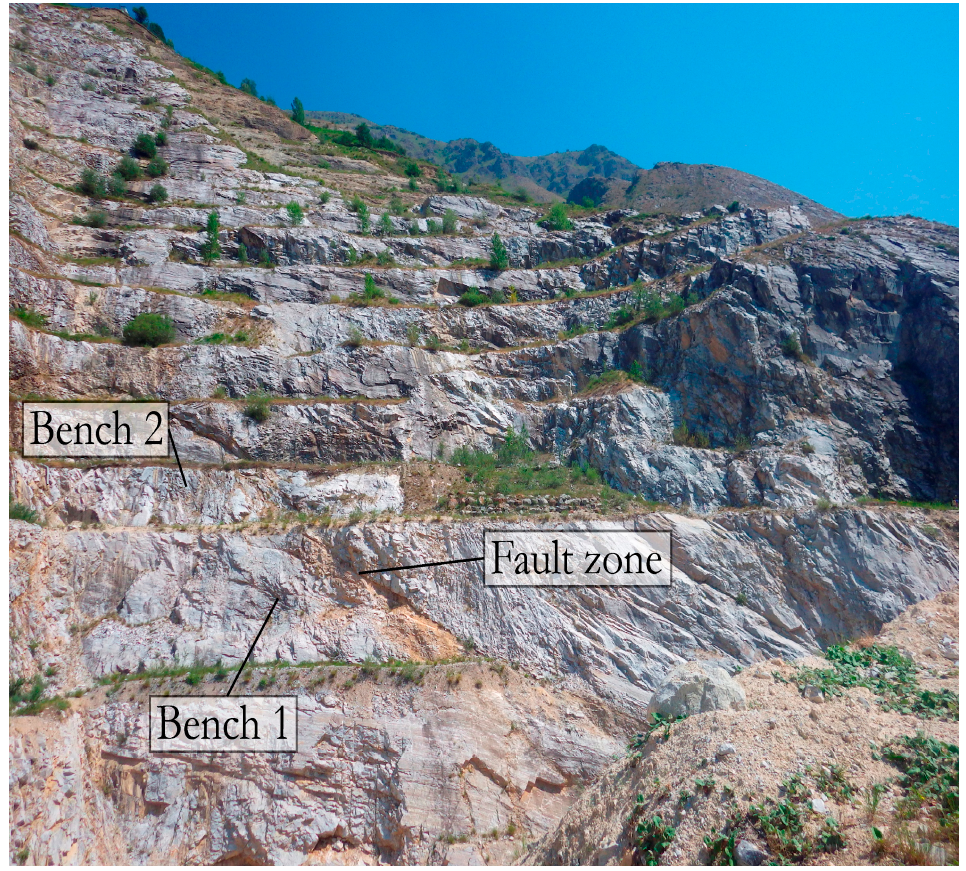
Figure 1. Overall perspective of the test site.